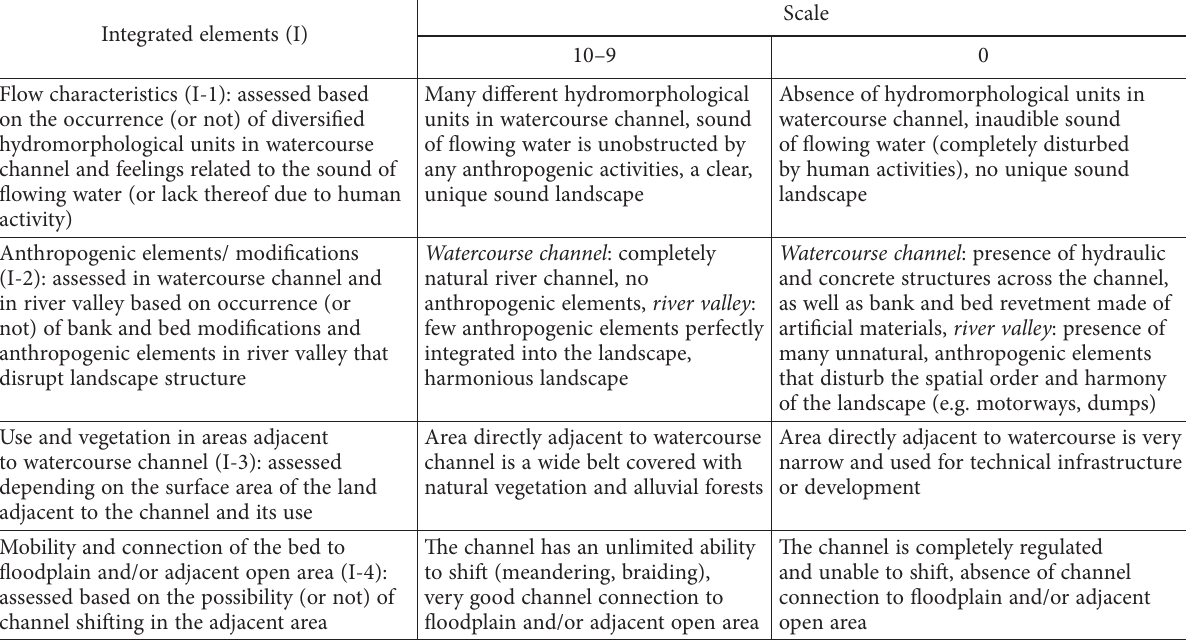
Table 3. Extreme values of integrated elements as per the LSHM Method (source: author’s study) Integrated elements